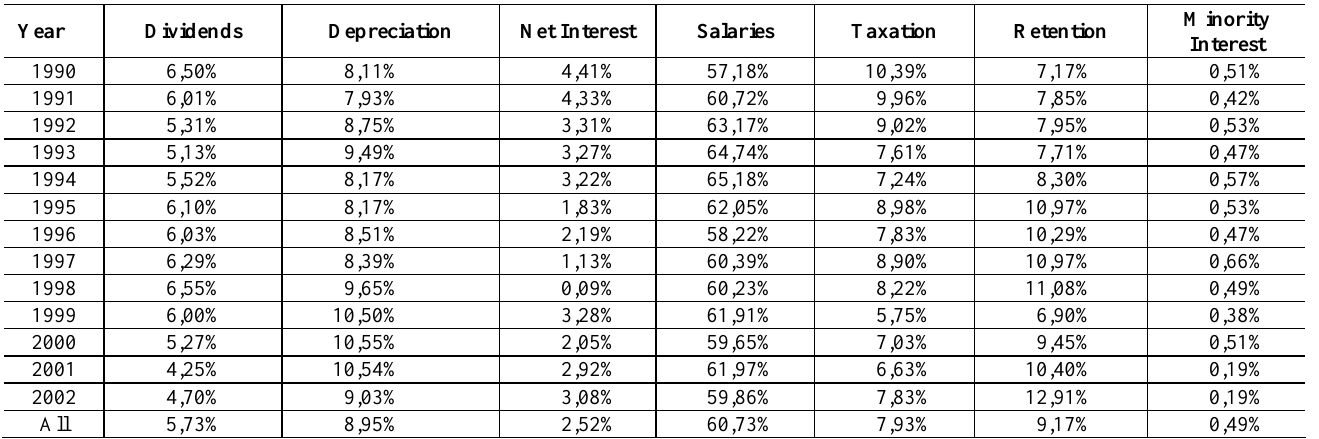
Table 8: Median values of distribution ratios – constant sample 1990 to 2002